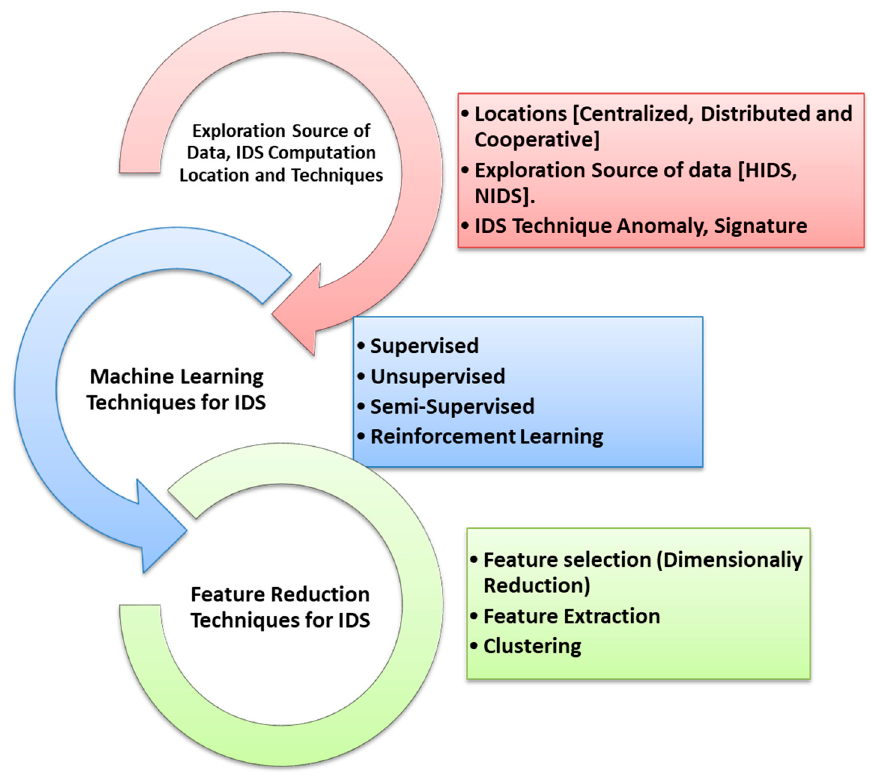
Figure 2. General architecture of a lightweight IDS based on the machine learning approach.